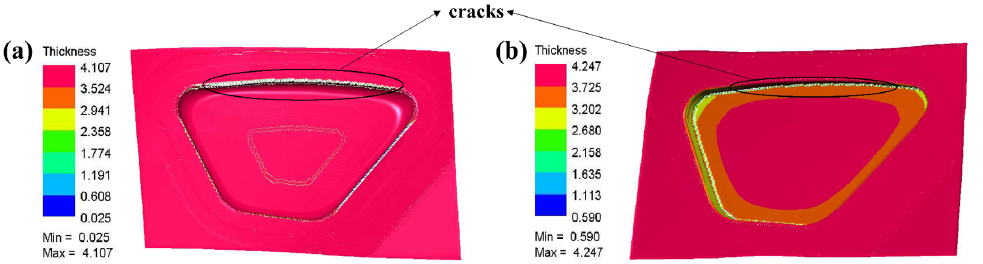
Figure 5. Effects of excessive punch depth and size; ( a ) Cracks in the top fillet due to excessive punch depth; ( b ) Cracks in the bottom fillet due to excessive punch size.